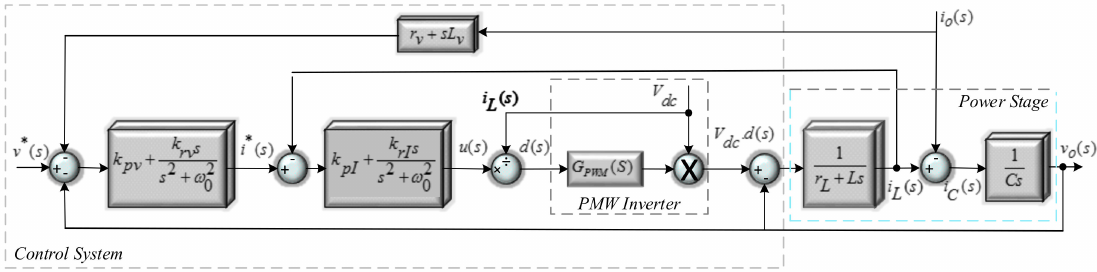
Figure 4. The block diagram of a positive-sequence controller.